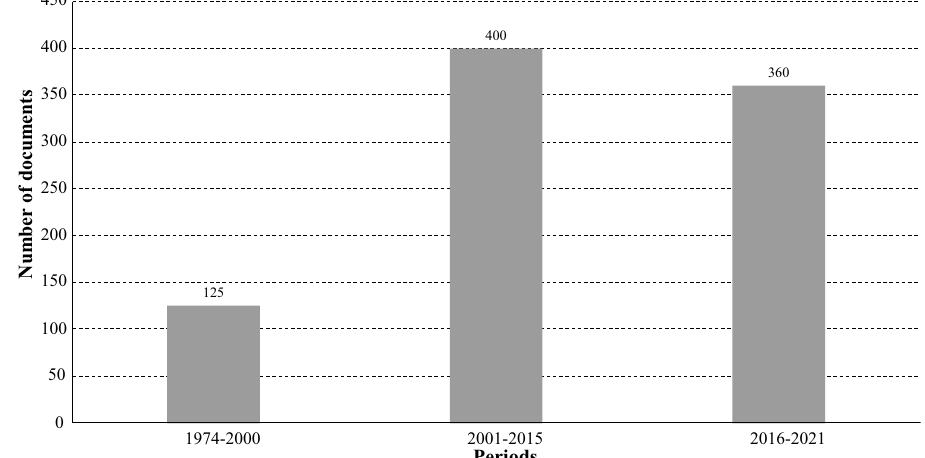
Fig. 3 Number of documents per